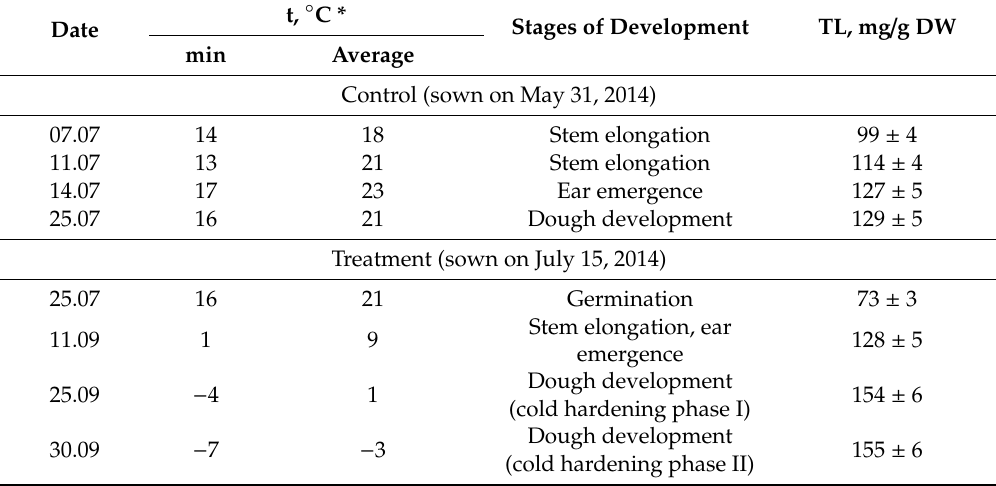
Table 1. Contents of total lipids (TL, mg / g dry weight ± standard error) in the leaves of the annual cereal Avena sativa sown on May 31 and July 15, 2014 at di ff erent stages of development and growing at di ff erent